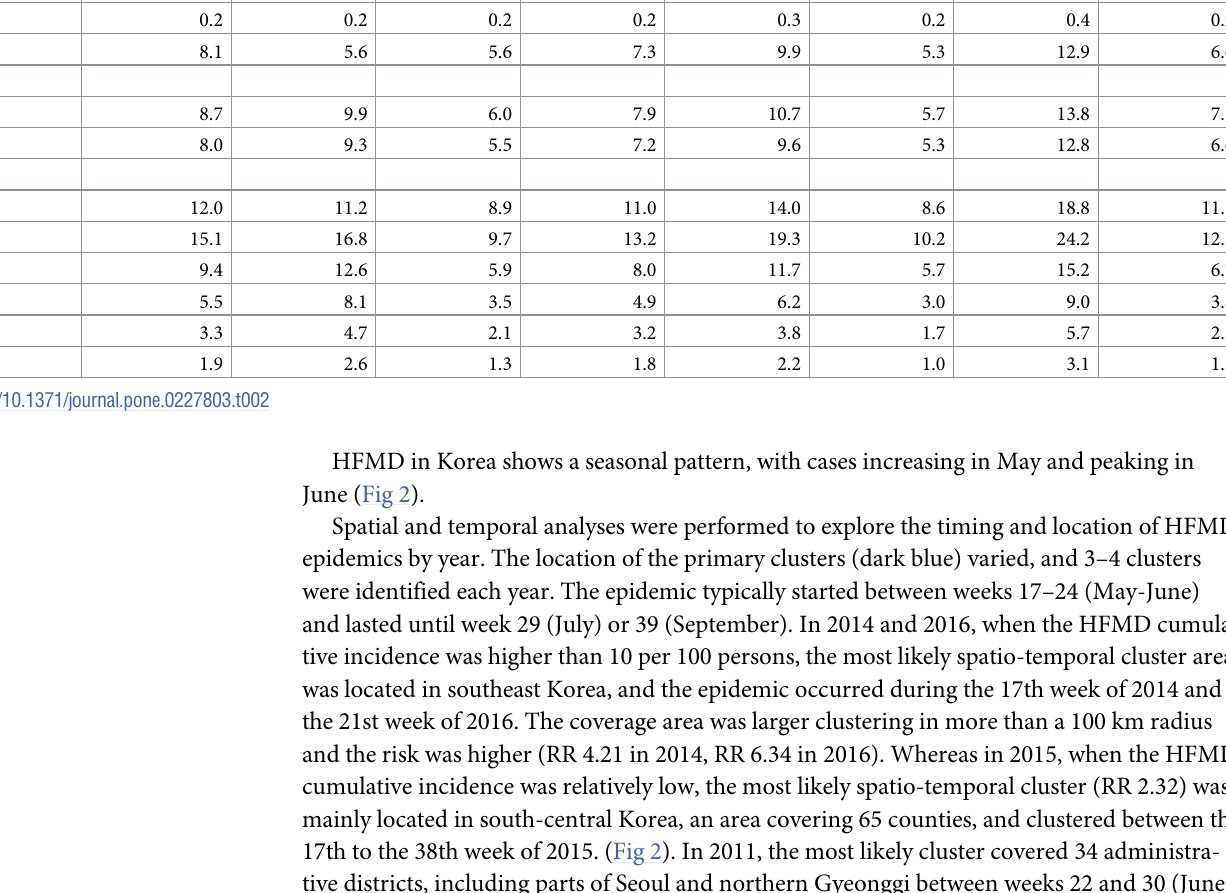
Table 2. The epidemiological characteristics of HFMD cumulative incidences in Korea(per 100 persons), 2011–2017.